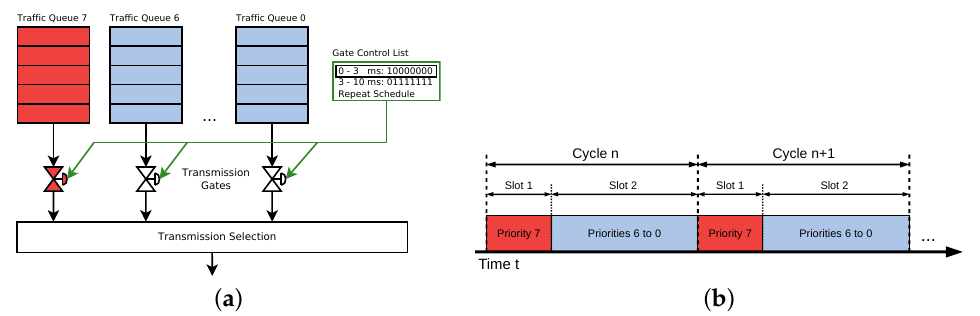
Figure 6. Methodology of Time-Aware Shaping (TAS). ( a ) shows the TAS components for transmis- sion selection within an egress port. ( b ) shows the corresponding serialization of the network traffic on